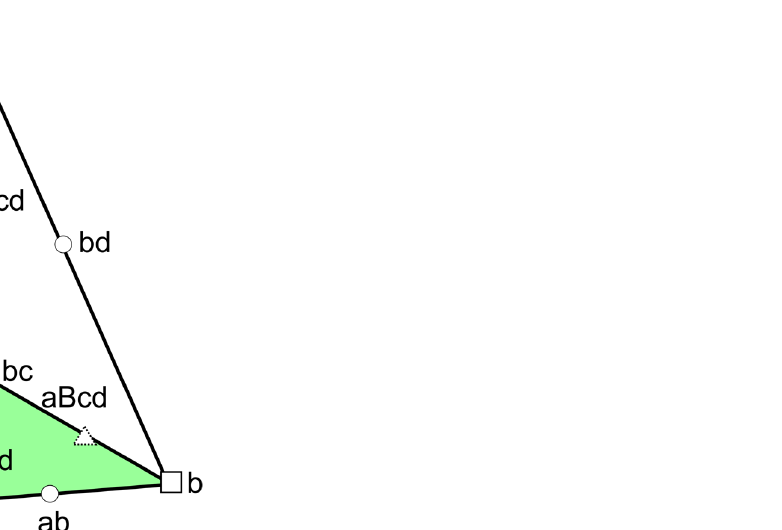
Figure 1. Schematic representation of simplex-lattice mixture design used to optimize essential oil mixtures: cedarwood (a), citronella (b), thyme (c), basil (d). The capital letter indicates the dominant ingredient in the mixture.